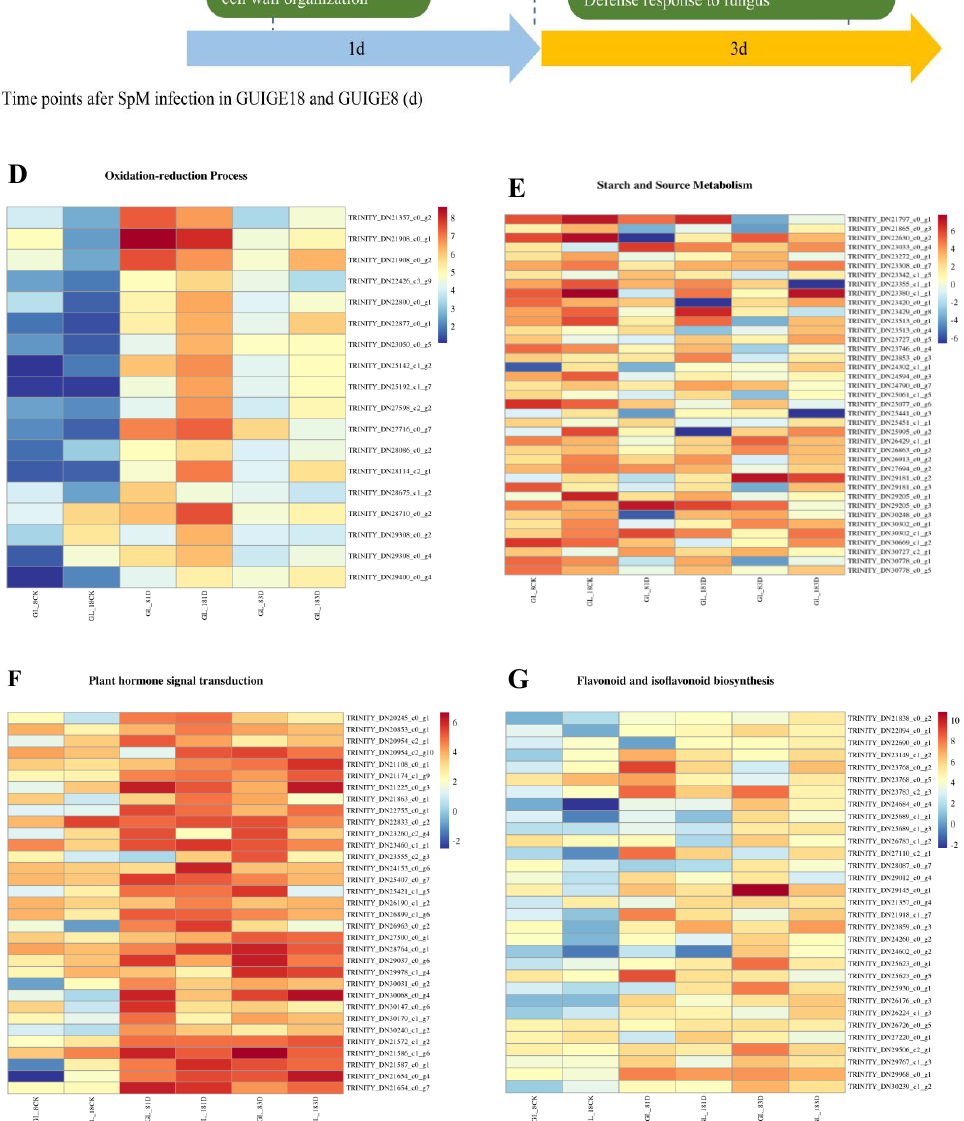
Figure 3. Gene Ontology (GO) enrichment and expression heatmap analysis of DEGs. ( A ) GO enrichment analysis of DEGs in GUIGE8; ( B ) GO enrichment analysis of DEGs in GUIGE18 − only the top 25 biological process (BP), 15 cellular component (CC), and 10 molecular function (MF) terms in each cluster are shown; ( C ) GO categories of up − regulated DEGs were significantly enriched in the BP and MF terms at different time points after SpM inoculation in the two cultivars; ( D ) expression heatmap analysis of DEGs related to the oxidation-reduction process; ( E ) expression heatmap analysis of DEGs related to starch and source metabolism; ( F ) expression heatmap analysis of DEGs